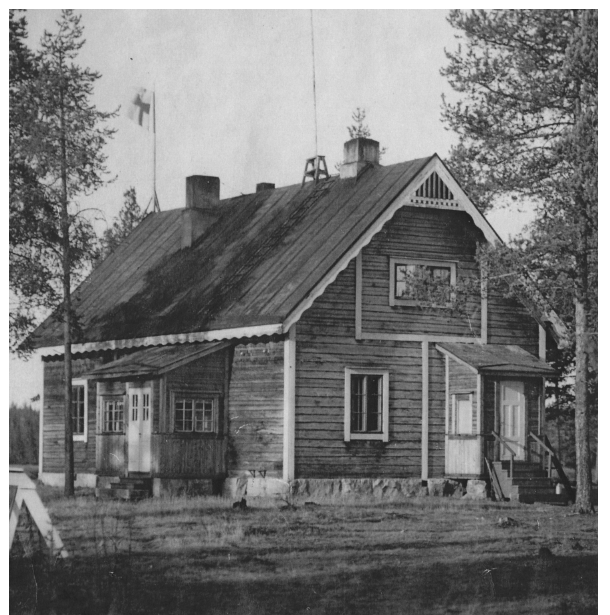
Figure 4. The main building of the Sodankylä Geophysical Obser- vatory in around 1930 (photo supplied by FMI).